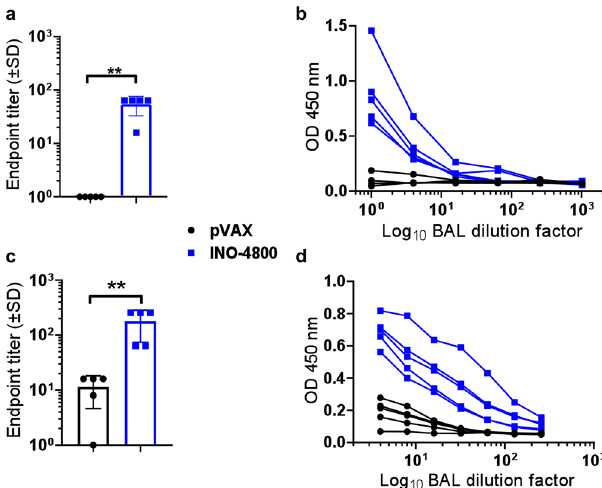
Fig. 7 Detection of SARS-CoV-2 S protein-reactive antibodies in the BAL of INO-4800 immunized animals. BALB/c mice (n of 5 per group) were immunized on days 0 and 14 with INO-4800 or pVAX and BAL collected at day 21 ( a , b ). Hartley guinea pigs ( n of 5 per group) were immunized on days 0, 14 and 21 with INO-4800 or pVAX and BAL collected at day 42 ( c , d ). Bronchoalveolar lavage fl uid was assayed in duplicate for SARS-CoV- 2 Spike protein-speci fi c IgG antibodies by ELISA. Data are presented as endpoint titers ( a , c ), and BAL dilution curves with raw OD 450 nm values ( b , d ). a , c Bars represent the average of each group and error bars the standard deviation. ** p < 0.01 by Mann – Whitney U